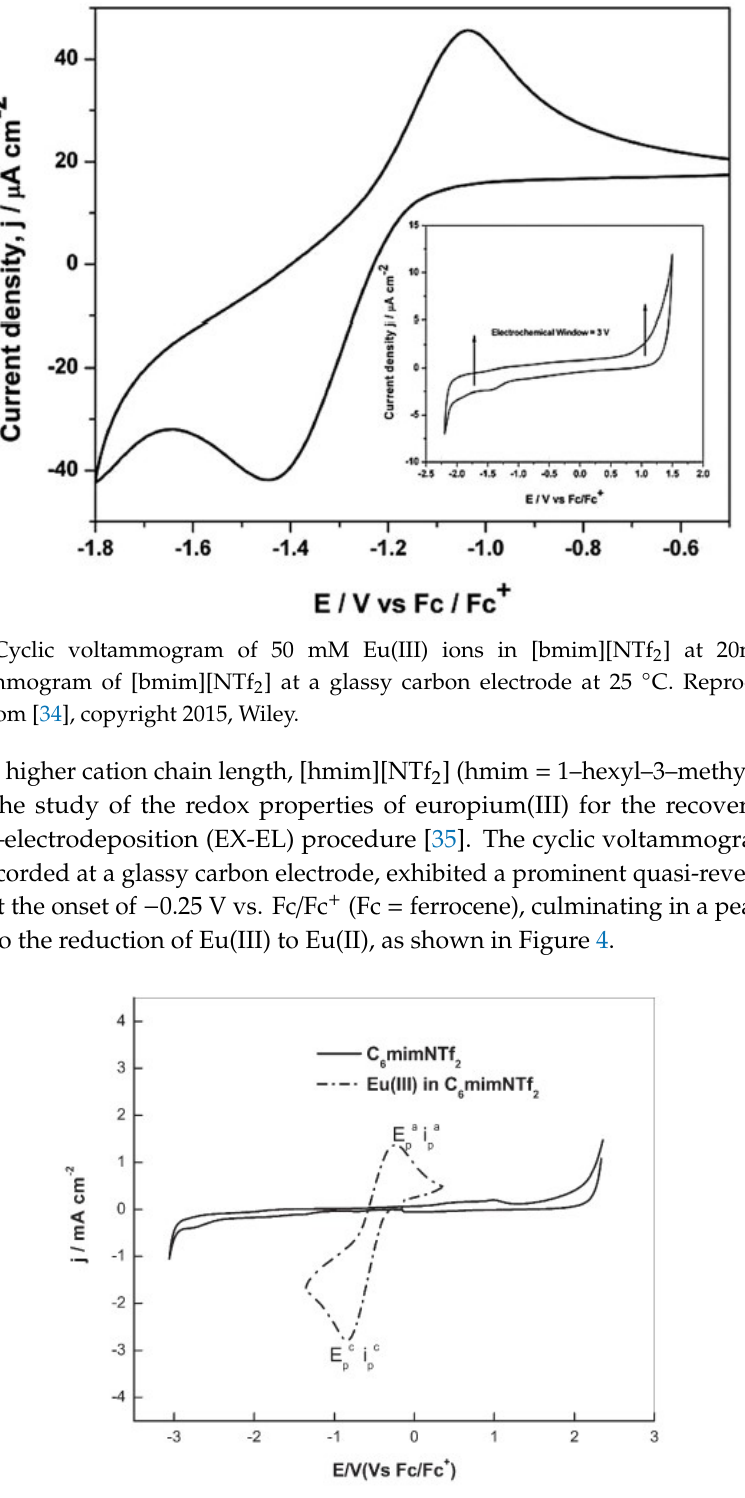
Figure 3. Cyclic voltammogram of 50 mM Eu(III) ions in [bmim][NTf 2 ] at 20mV/s. Inset: Cyclic voltammogram of [bmim][NTf 2 ] at a glassy carbon electrode at 25 °C. Reproduced with permission from [34], copyright 2015, Wiley.